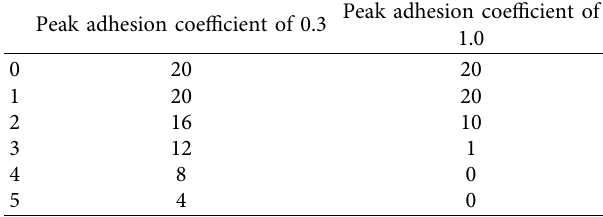
Table 2: Speed of vehicle 1 at different peak adhesion coefficients (Km/h).